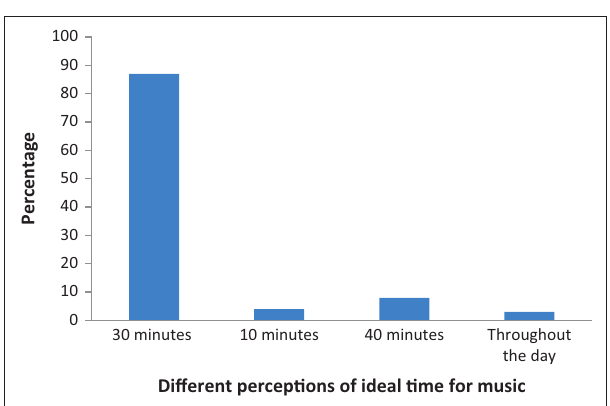
FIGURE 6: Students’ post-course perceptions of ideal music engagement time for young